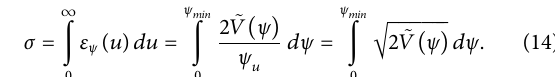
FIGURE 3 Numericalsolutionof(11)underboundaryconditions:theleft minimum ~ V ( ψ ) (Figure2)isreachedinsidethebubble ψ (0)=0,and the right minimum is reached for the remote observer ψ ( u → ∞ ) = ψ min (and forms our Universe). In the graphs: the blue line is the direct solution of ψ ( u ) (domain wall) and the red dashed line is itscorrespondingfunction ϕ ( u ).Inthisexamplethebubbleradiusis ≈ 8 · 10 13 . u 0